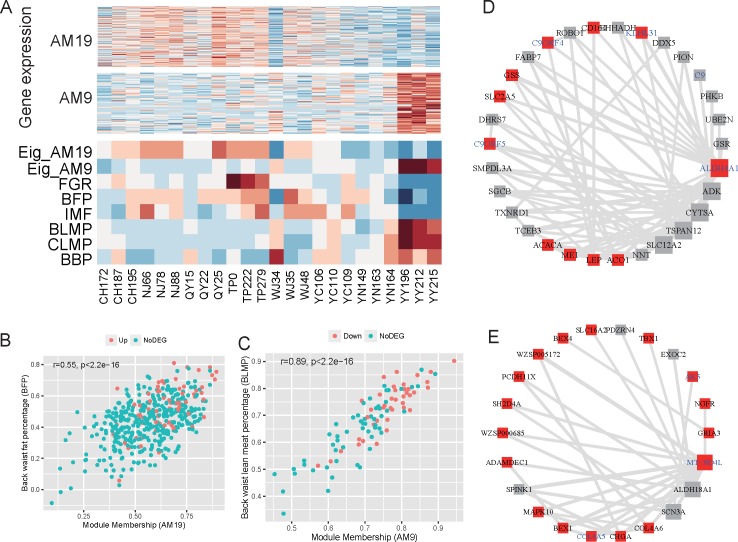
Adipose modules AM19 and AM9 are significantly correlated with the fat and lean meat phenotypic traits.(A) The expression and eigengene values of modules AM19 and AM9 have opposite correlations with the phenotypic traits. Each row in the heatmaps was normalized, with red denoting a higher Z score of the expression (measured using RPKM) or the phenotypic measurements, and blue denoting a lower one. In the expression section, each row represents one gene. Eig_AM19 and Eig_AM9 represent the module eigengenes of AM19 and AM9, respectively. Each column represents one individual pig. FGR: feed/gain ratio, BFP: back waist fat percentage, IMF: intramuscular fat content, BLMP: back waist lean meat percentage, CLMP: carcass lean meat percentage, BBP: back waist bone percentage. (B) Gene significance of back waist fat percentage is positively correlated with the module membership in AM19. Red denotes upregulation in Chinese breeds. (C) Gene significance of back waist lean meat percentage is positively correlated with module membership in AM9. (D) The network of the top 30 genes with the highest module membership in module AM19; only the edges with topological overlap above a threshold of 0.05 are displayed. The rectangle represents the DEGs between Chinese breeds and Yorkshire. (E) The network in module AM9 with the same criteria as those in D. The coexpression networks reflect the degree of topological overlap (the size of the vertex), the DEGs (the red color of the vertex), and the QTL association (the blue color of the label).